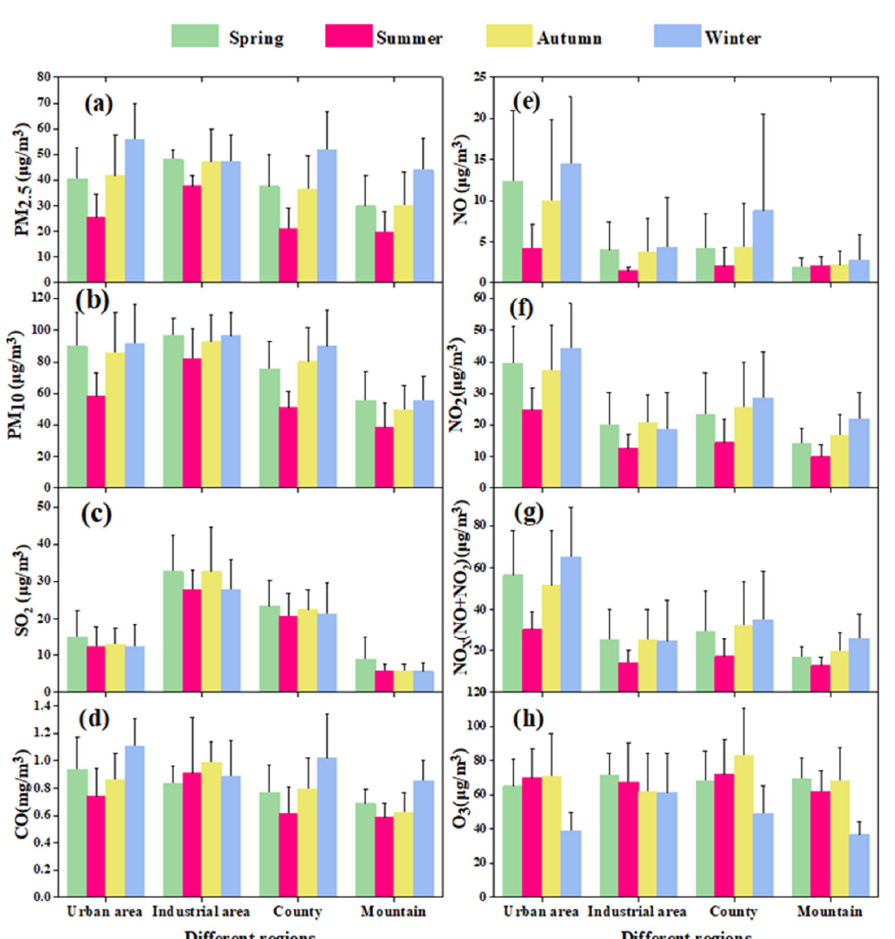
Figure 4. Seasonal mean concentrations of air pollutants: ( a ) PM 2.5 ; ( b ) PM 10 ; ( c ) SO 2 ; ( d ) CO; ( e ) NO; ( f ) NO 2 ; ( g ) NOx (NO + NO 2 ); ( h )O 3 .